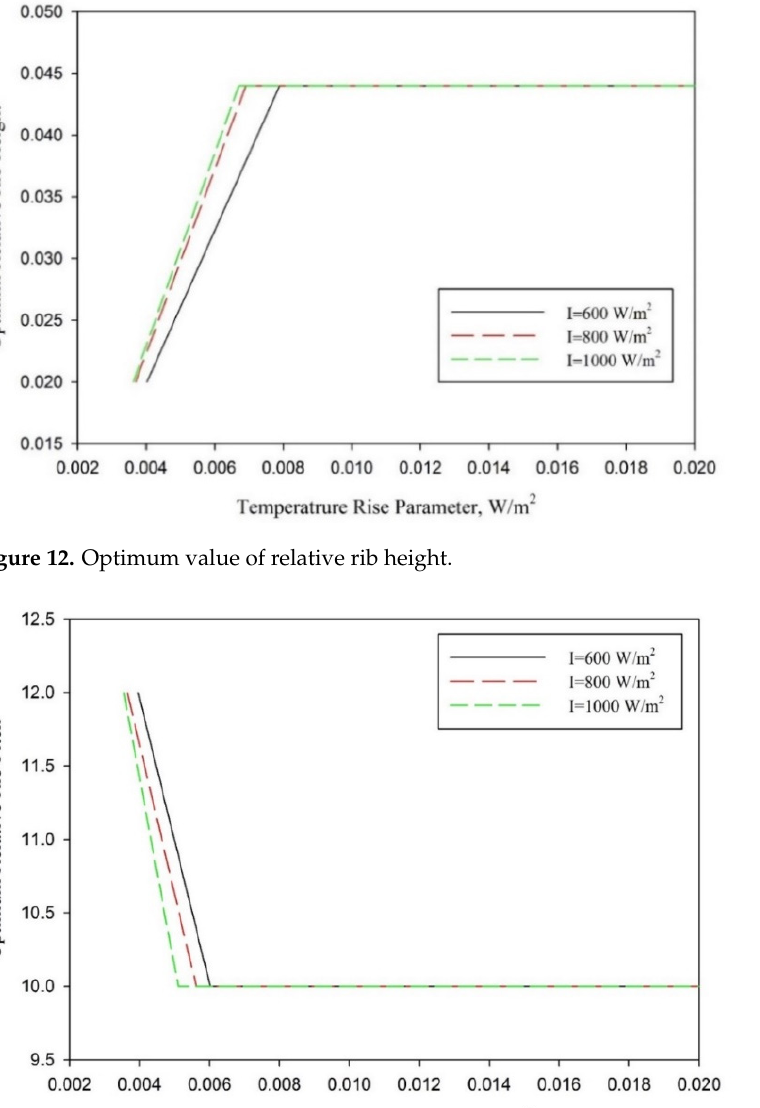
Figure 12. Optimum value of relative rib height.